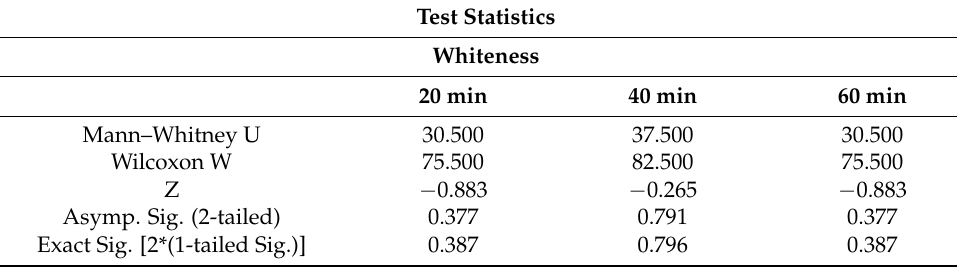
Table A3. Test statistics table of Mann–Whitney U test for the whiteness, according to the holding time.